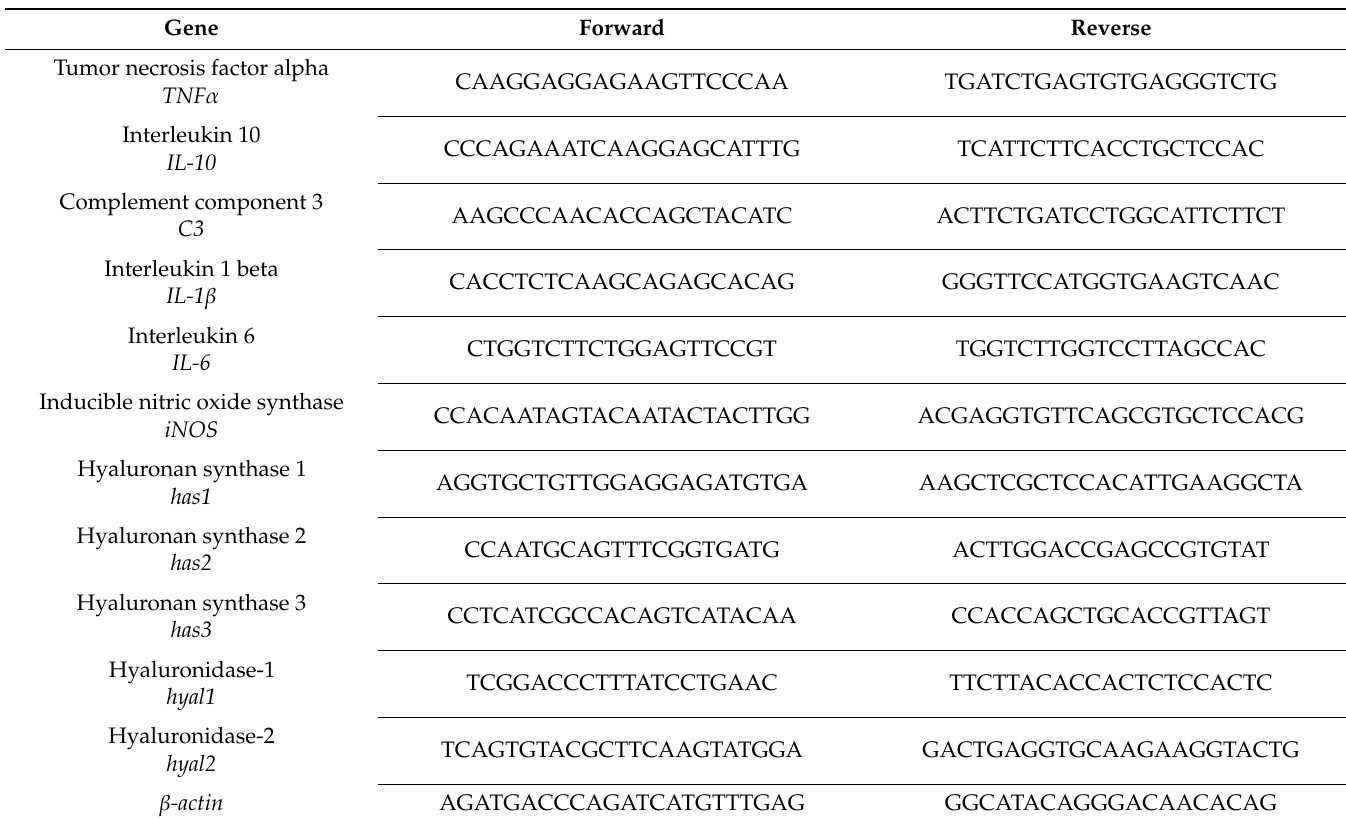
Table 1. DNA Sequences of the Primers used for